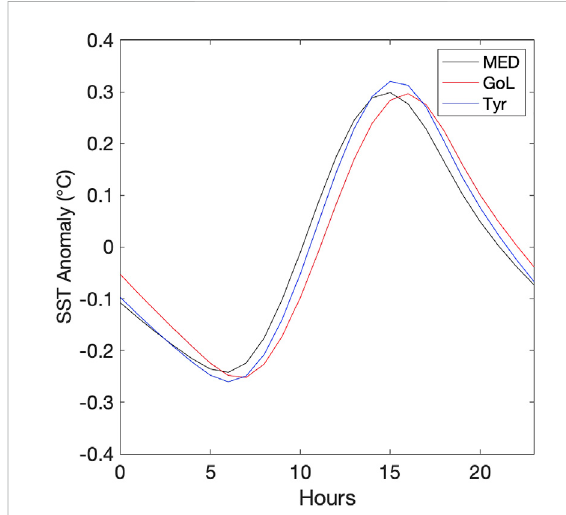
FIGURE 4 The SST diurnal Cycle for Mediterranean Basin Gulf of Lion and the Southern Tyrrhenian sea.